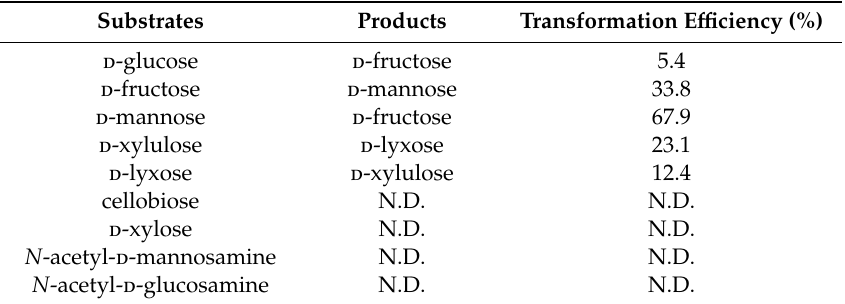
Table 2. Substrate specificity of recombinant P. geniculata AGEase.